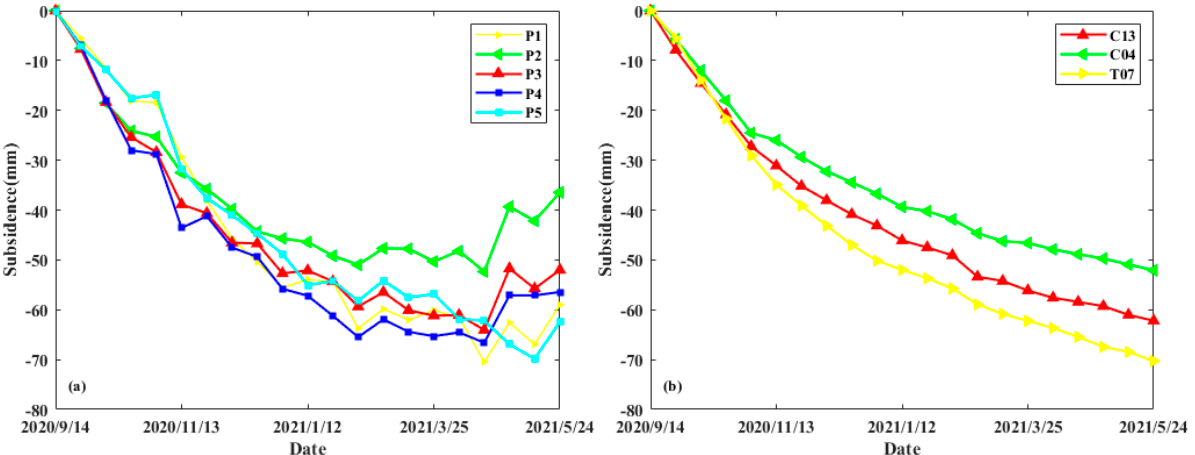
Figure 7. ( a ) Accumulated subsidence at the SBAS-InSAR monitoring site; ( b ) measured data at the level point.